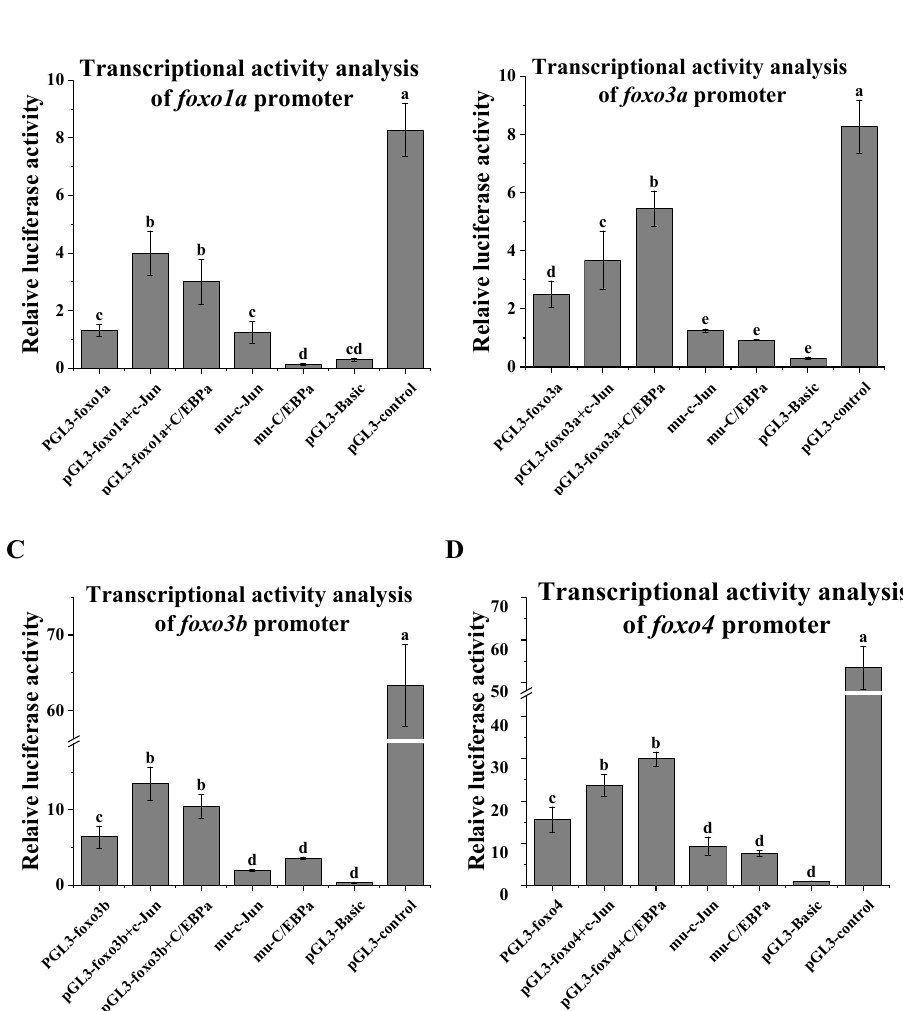
Figure 5. Transcriptional activity of the Csfoxo1a , Csfoxo3a , Csfoxo3b , and Csfoxo4 promoters: ( A ) Csfoxo1a ; ( B ) Csfoxo3a ; ( C ) Csfoxo3b ; ( D ) Csfoxo4 . Results correspond to the addition of c-Jun and C/EBP α transcription factors, and the effect on the mutation of two transcription-factor-binding sites. Different letters indicate significant differences, and bars represent standard deviations.